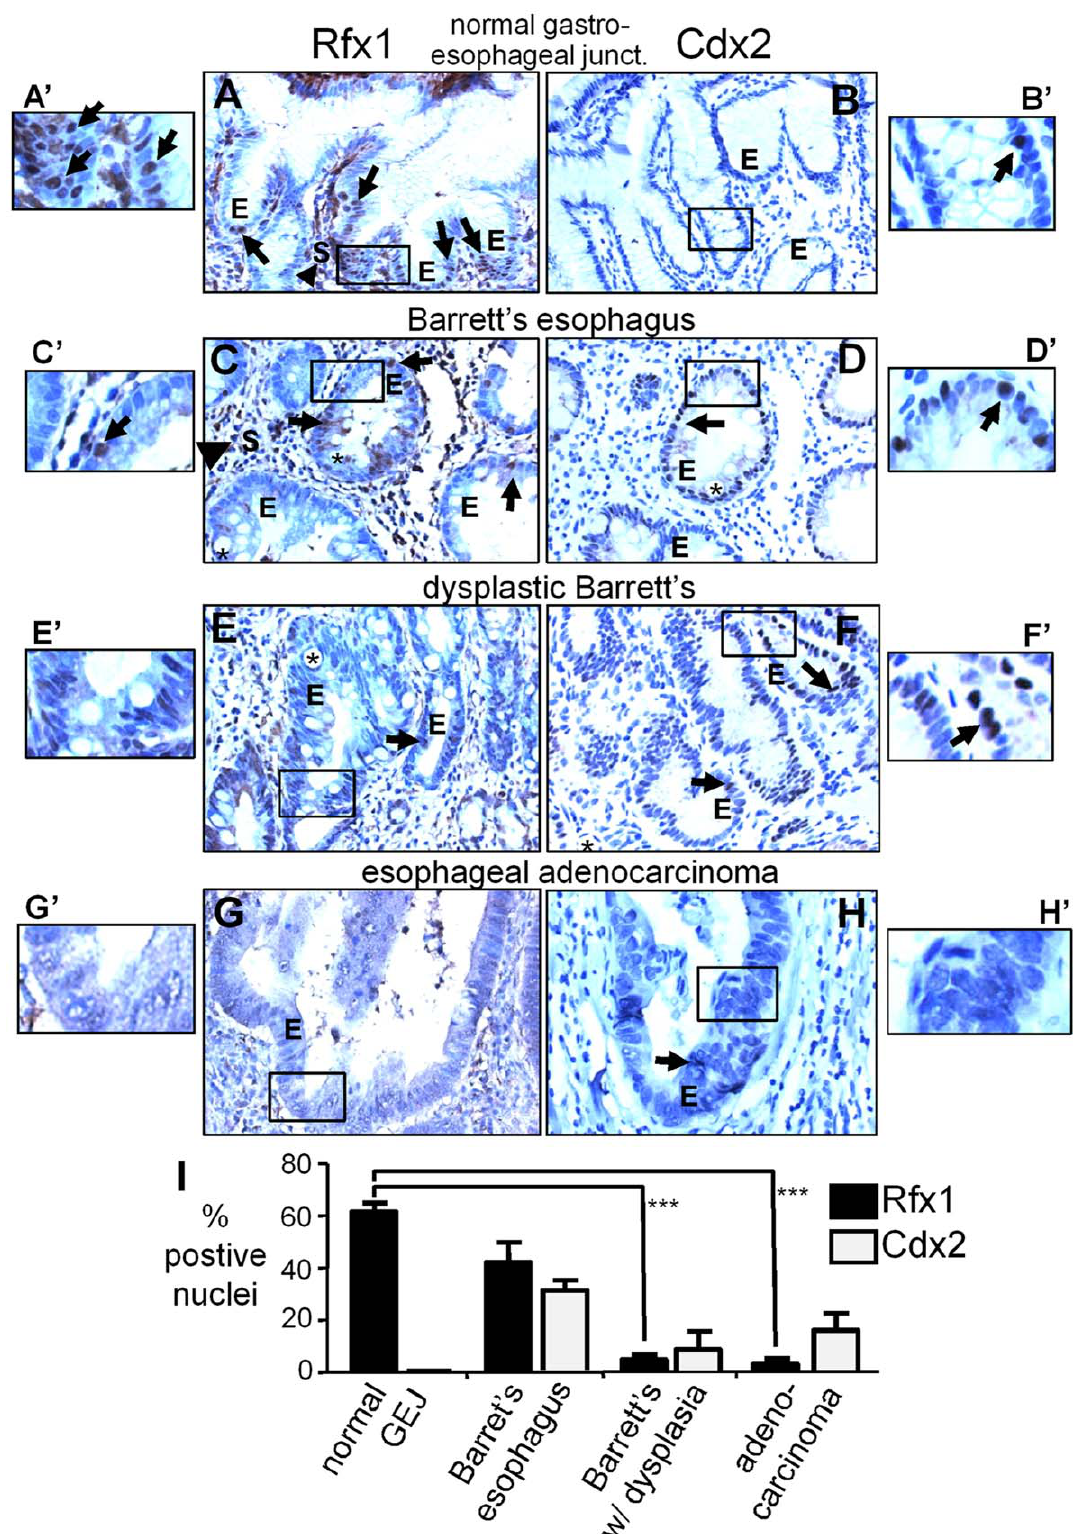
Figure 5. Rfx1 downregulation in esophageal adenocarcinoma. (A–H) Immunohistochemisty of Rfx1 and Cdx2 expression in: (A, B) normal glandular epithelium of the gastro-esophageal junction, (C, D) Barrett’s esophagus, (E, F) Barrett’s esophagus with dysplasia, and (G, H) esophageal adenocarcinoma. Arrows indicate Rfx1 or Cdx2 positive nuclei in the epithelium (E); arrowheads indicate Rfx1 positive nuclei in the stroma(s). Asterisks indicates large secretory vacuoles characteristic of intestinal metaplasia (Barrett’s esophagus). (A 9 –H 9 ) higher magnification views of the regions boxed in A–H. (I) Graph of the average percentage of Rfx1 positive nuclei at the indicated stages. Error bars indicate the standard error of the